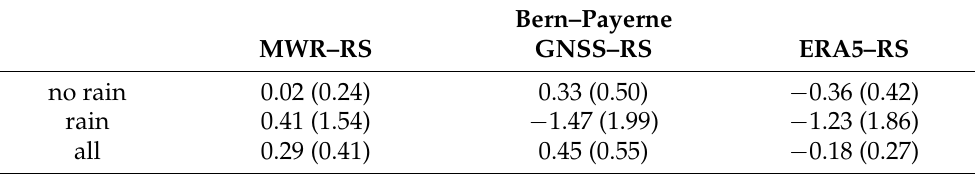
Table 6. Mean differences of IWV (mm) and RMSE of MWR (microwave radiometer), GNSS and ERA5 at Bern with respect to the radiosonde at Payerne. The deviations are listed for the different atmospheric states using the monthly means of Figure 5. The IWV data of the Payerne radiosonde are corrected by considering the height difference between Payerne and Bern. All values are calculated for the time interval 1 January 2004 to 31 December